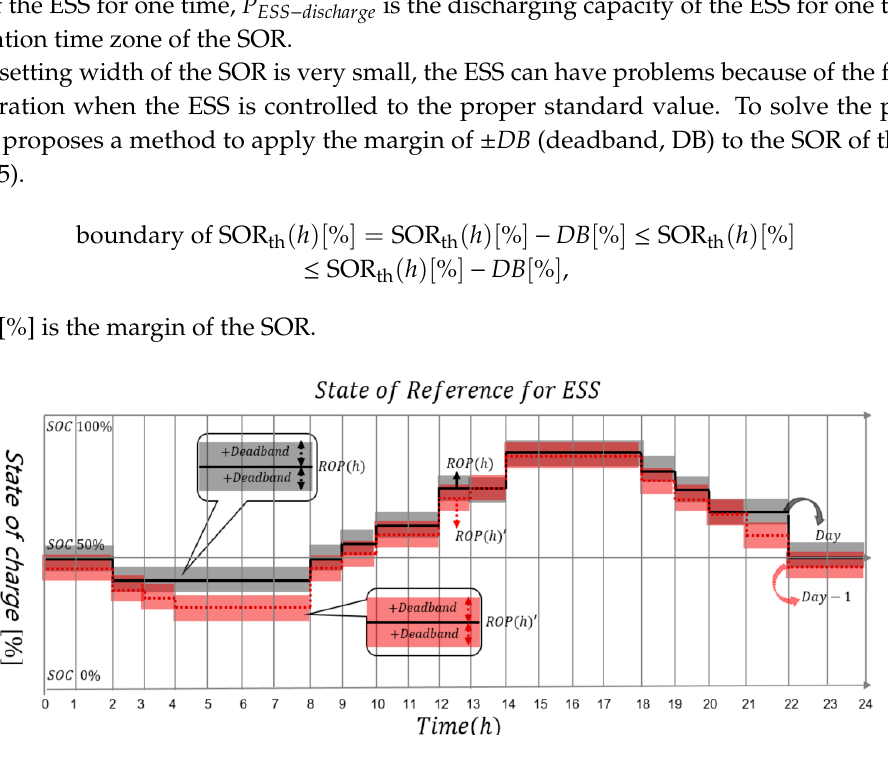
Figure 8. Concept of estimation method for state of reference of an ESS.